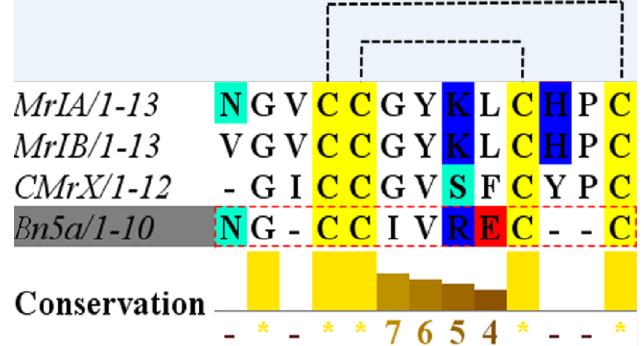
Figure 8. Multiple sequence alignment of Bn5a and three other bioactive compounds with different cysteine frameworks: Residue conservation score was calculated via the software Jalview v2.8. The dotted line indicates disulfide connectivity. Gaps have been presented to optimize the alignment sequence identity. Color coding employs the following scheme: hydrophobic residues are in white, negatively charged residues in red, positively charged residues in blue, polar uncharged residues in green, and cysteine residues in yellow. The color intensity and the “conservation index” score (1–11) reflect the conservation of physicochemical properties of amino acids in the particular column of the alignment. *conserved column (where the highest score is